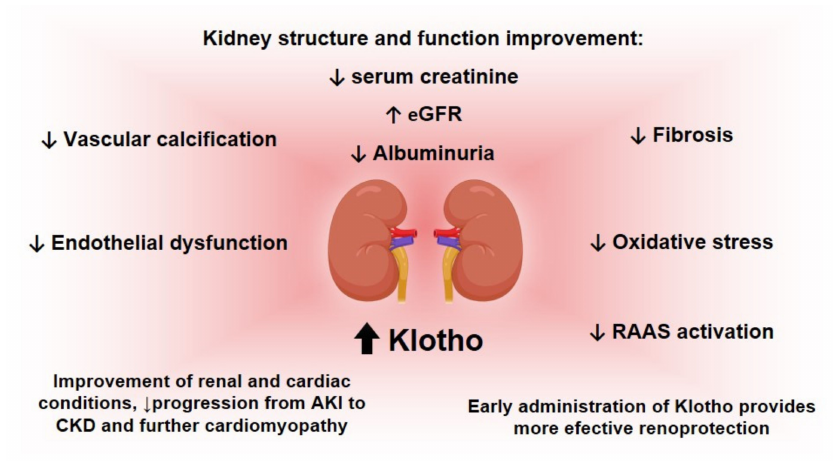
Figure 3. Renal benefits after restoration of Klotho levels. The figure shows some of the benefits for kidneys obtained with the reestablishment of Klotho levels, concerning the progression of acute kidney disease (AKI) and chronic kidney disease (CKD) and other phenotypes associated with these diseases. Klotho ameliorates processes involved in the advancement of renal diseases, such as the inhibition of the renin-aldosterone-angiotensin system (RAAS), fibrosis and oxidative stress. In addition, Klotho also reduces vascular calcification and vascular dysfunction and it promotes the improvement of renal structural and functional conditions, such as an increase in the estimated glomerular filtration rate (eGFR) and a decrease in serum creatinine.